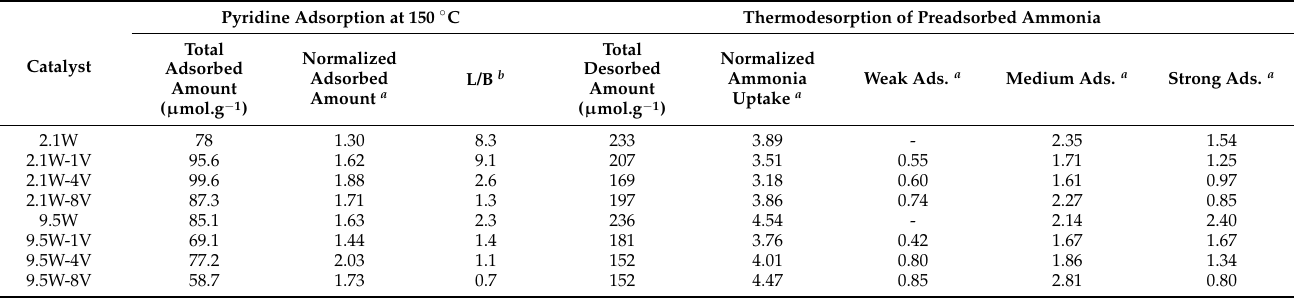
Figure 9. IR spectra recorded for pre-adsorbed pyridine 2.1W- x V ( A ) and 9.5W- x V ( B ) samples evacuated at 150 ◦ C: x = 0 ( a ); x = 1 ( b ); x = 4 ( c ); x = 8 ( d ). Table 6. Characterization from pyridine and ammonia of acidic site and ammonia adsorption capacity of V 2 O 5 -WO 3 /TiO 2 catalysts.